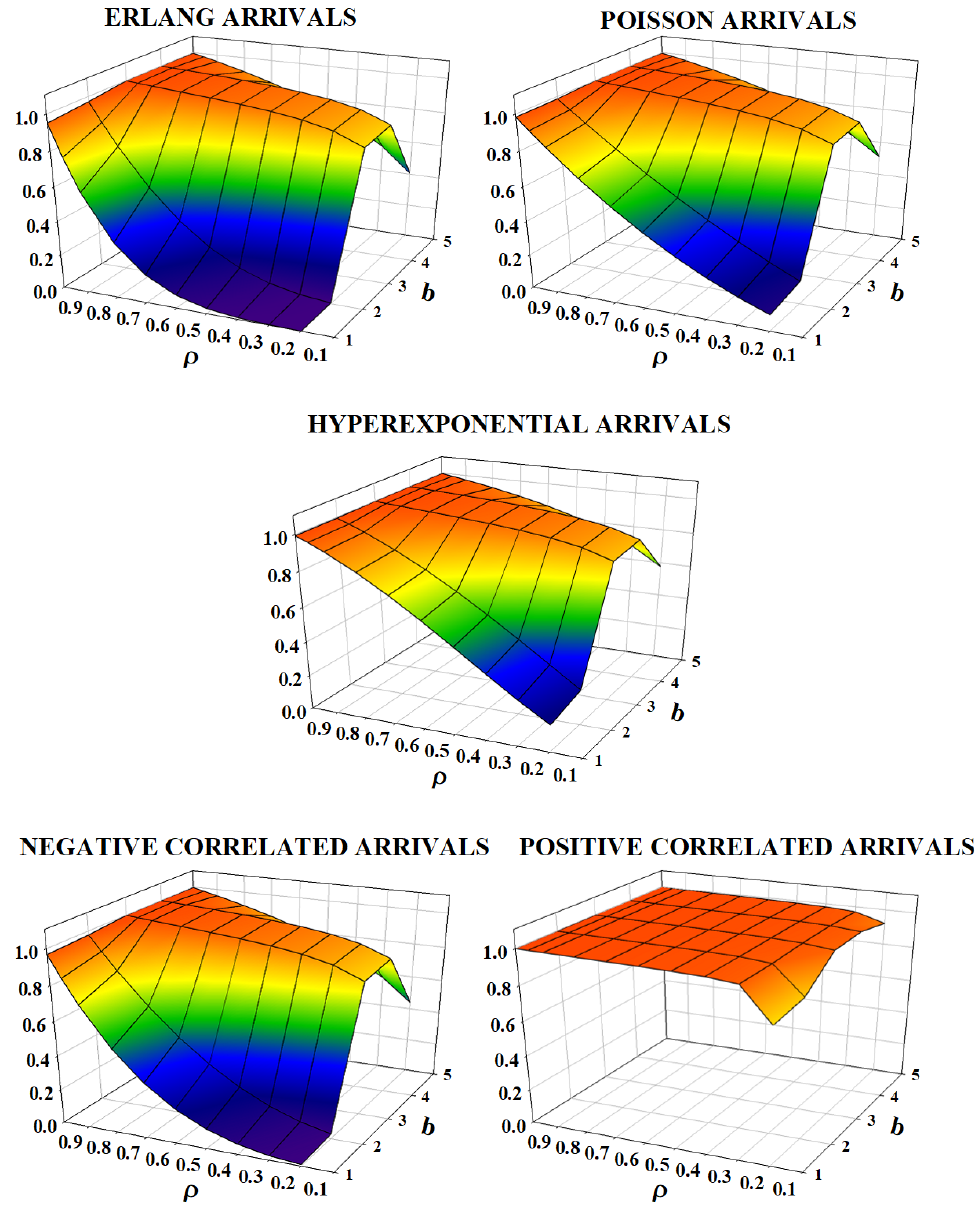
Figure 15. Spectral radius ( η ) for example